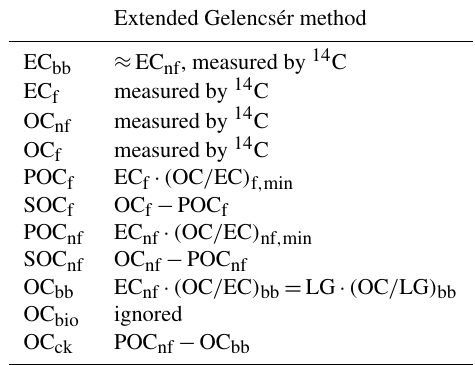
Table 1. Equations for 14 C-based source apportionment; see Sect. 3.2 for